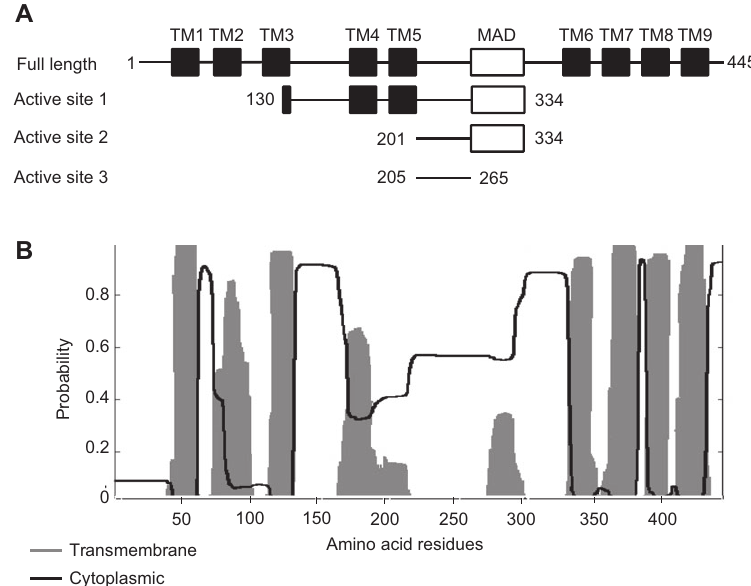
Figure 1 Domains, location of fragments and hydrophobicity of human alkylglycerol monooxygenase. (A) Schematic secondary structure of full-length alkylglycerol monooxygenase and truncations (active site 1, active site 2 and active site 3) based on Watschinger et al. [ 5 ]. Full- length alkylglycerol monooxygenase (amino acid stretch 1 – 445) has nine proposed transmembrane (TM) regions and a membrane-asso- ciated domain (MAD). Active site 1 (amino acid stretch 130 – 334) has two proposed TM regions (TM4, TM5) and a MAD. Active site 2 (amino acid stretch 201 – 334) lacks TM regions but incorporates a proposed MAD. Active site 3 (amino acid stretch 205 – 265) lacks TM regions and MADs and was proposed to be cytoplasmic. (B) Hydrophobicity blot of full-length alkylglycerol monooxygenase performed with Phobius [ 6 ]. Proposed TM motifs are shaded in grey. Proposed cytoplasmic regions are shown with a black